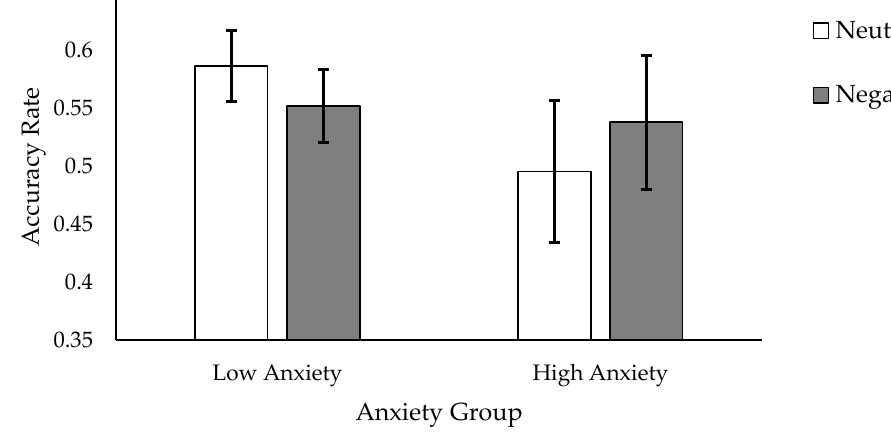
Figure 2. Mean accuracy rates on Test 2 for foils derived from the neutral and negative Test 1 subtests for low and high anxiety groups, following shallow encoding of targets. Error bars show the standard error.